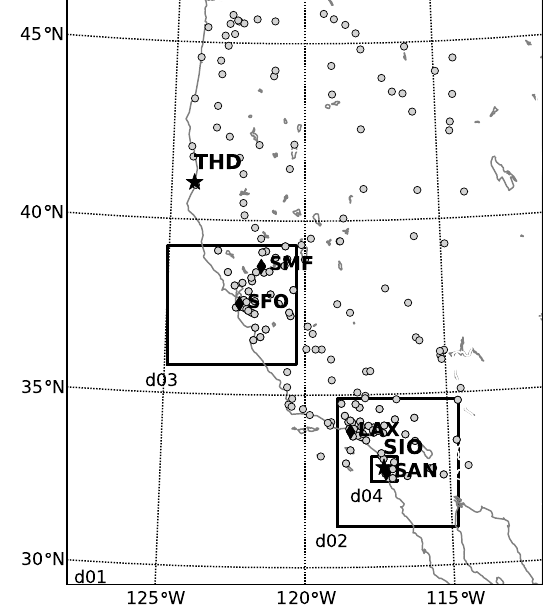
Fig. 1. WRF domain with the coarse (12km) domain (d01) and three higher resolution nests (d02 and d03 at 4km resolution and d04 at 0.8km resolution). Airports (SAN: San Diego, LAX: Los Angeles, SFO: San Francisco, SMF: Sacramento) are plotted as black diamonds. The measurement sites of La Jolla (SIO) and Trinidad Head (THD) are indicated by a black star. Location of the METAR surface weather stations is shown with a grey dot.